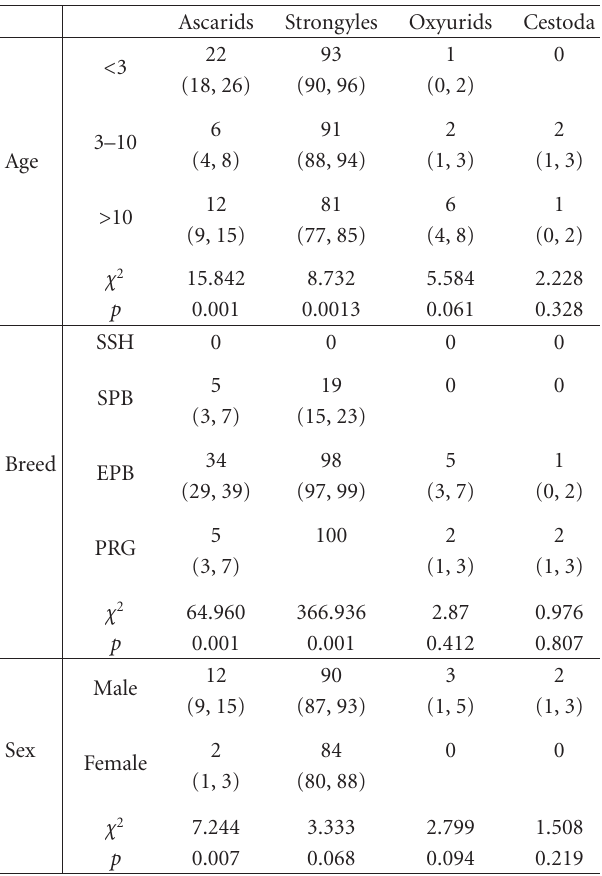
Table 2: Prevalences of helminth parasites in 418 horses from an oceanic climate area (NW Spain). Results are expressed as the percentage and the 95% Confidence Interval (CI). Spanish Sport Horse (SSH), Spanish Pure Breed (SPB), English Pure Breed (EPB), autochthonous Pura Raza Galega (PRG).